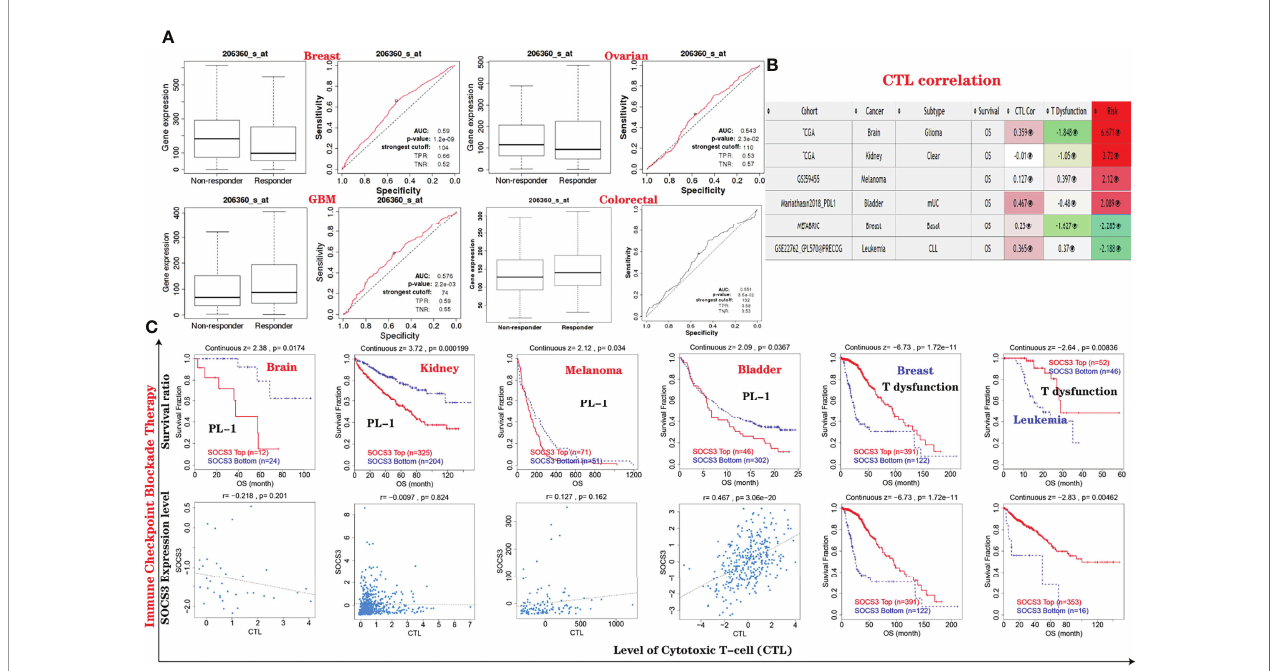
FIGURE 11 | SOCS3 expression is relevant to the treatment of disparate cancers. (A) Relationship between SOCS3 expression and responses to chemotherapy in breast, ovarian, brain and colorectal cancers, which is displayed via ROC curve plot. (B, C) Employed TIDE database to indicate the correlations between immunotherapeutic response (ICB) and cytotoxic T-cell level (CTL) and SOCS3 expression levels in TCGA cancers using Kaplan – Meier curves. Only cancers with statistically signi fi cant differences were